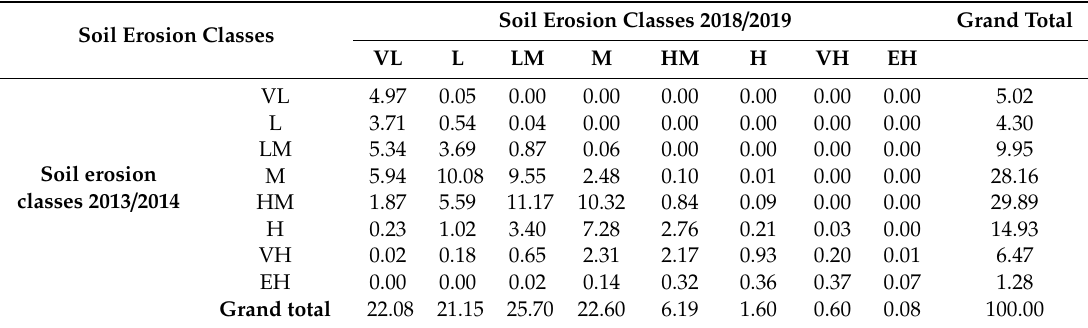
Table 3. Change the soil erosion matrix classes from 2013 / 2014 to 2018 / 2019 (%). Soil Erosion Classes 2018 / 2019 Soil Erosion Classes